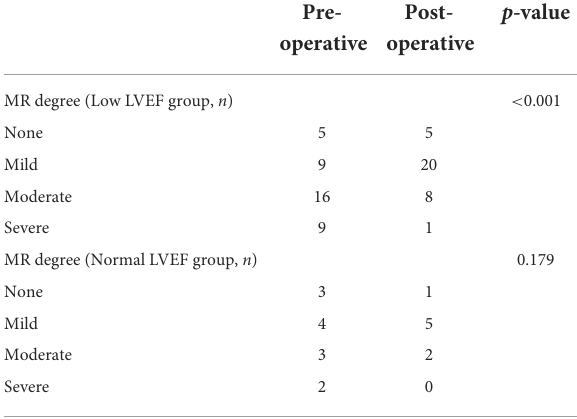
TABLE 4 Comparison between pre- and post-operative MR